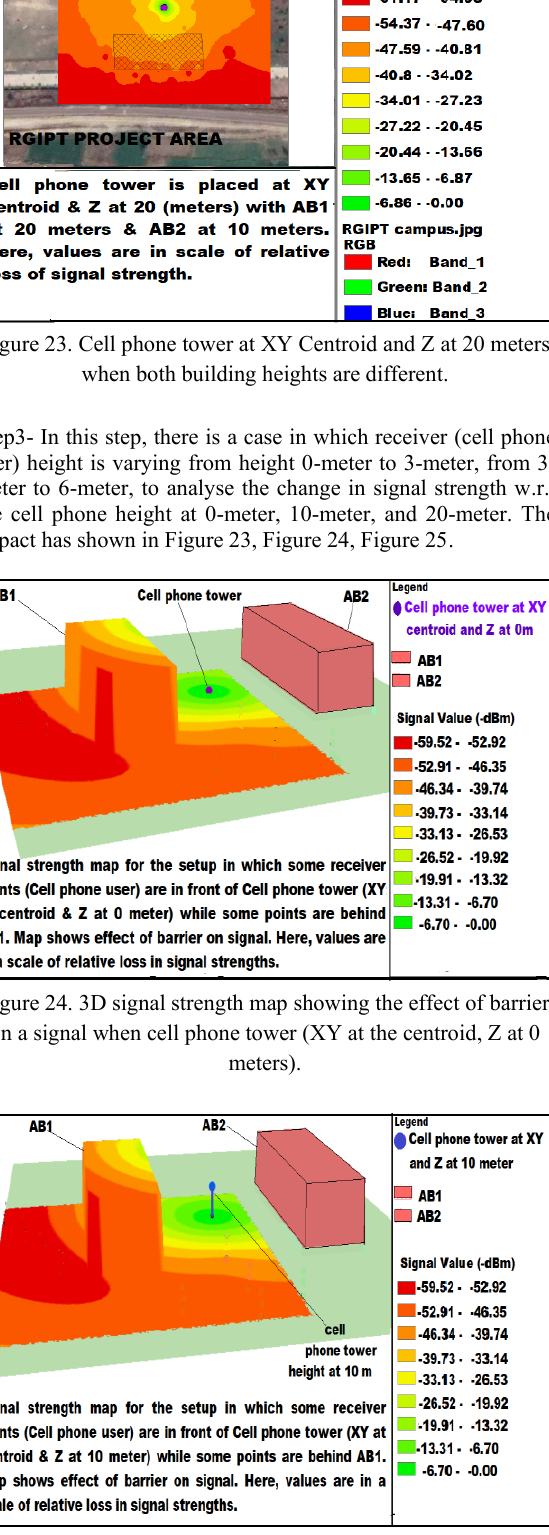
Figure 25. 3D signal strength map showing the effect of barrier on a signal when cell phone tower (XY at the centroid, Z at 10